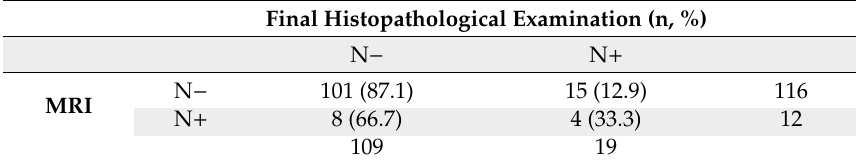
Table 3. Concordance between MRI and final histopathological examination on lymph node extension.